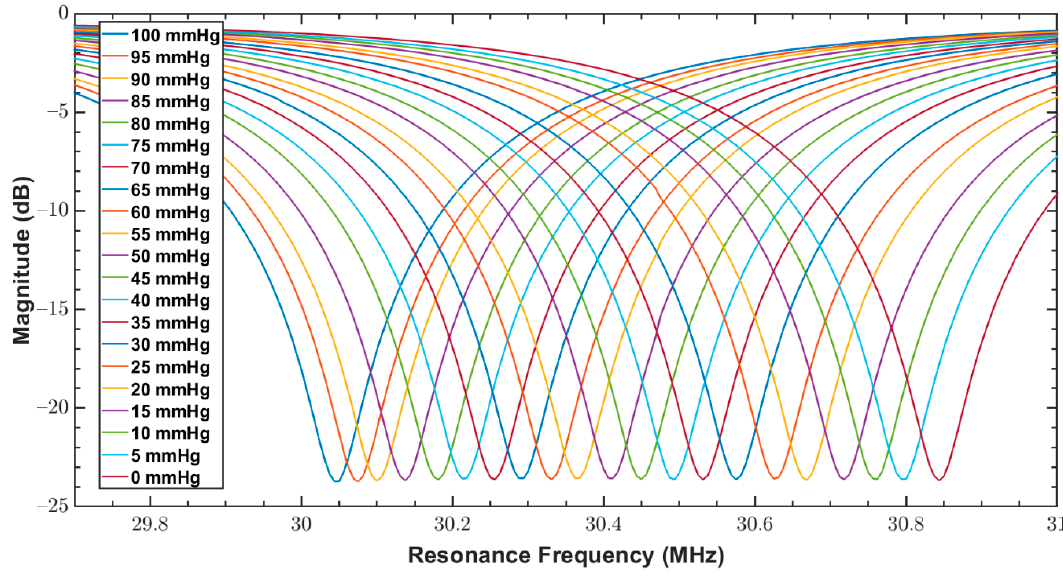
Figure 11. Reflection coefficients (S11 parameter) of S 1 for a pressure range of 0 to 100 mmHg.